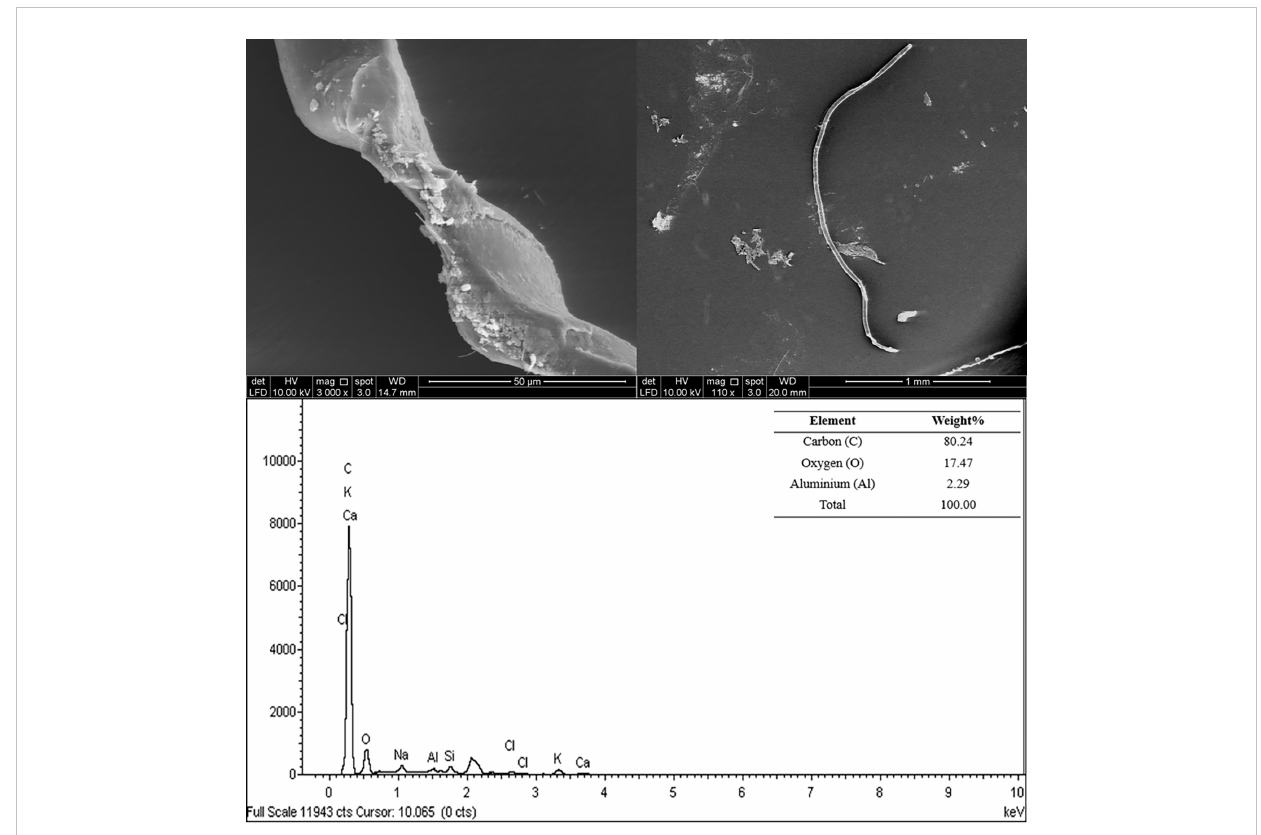
FIGURE 7 FESEM images of aged fi bre and the corresponding EDX spectra of aged fi bre recovered from the estuarine environment of